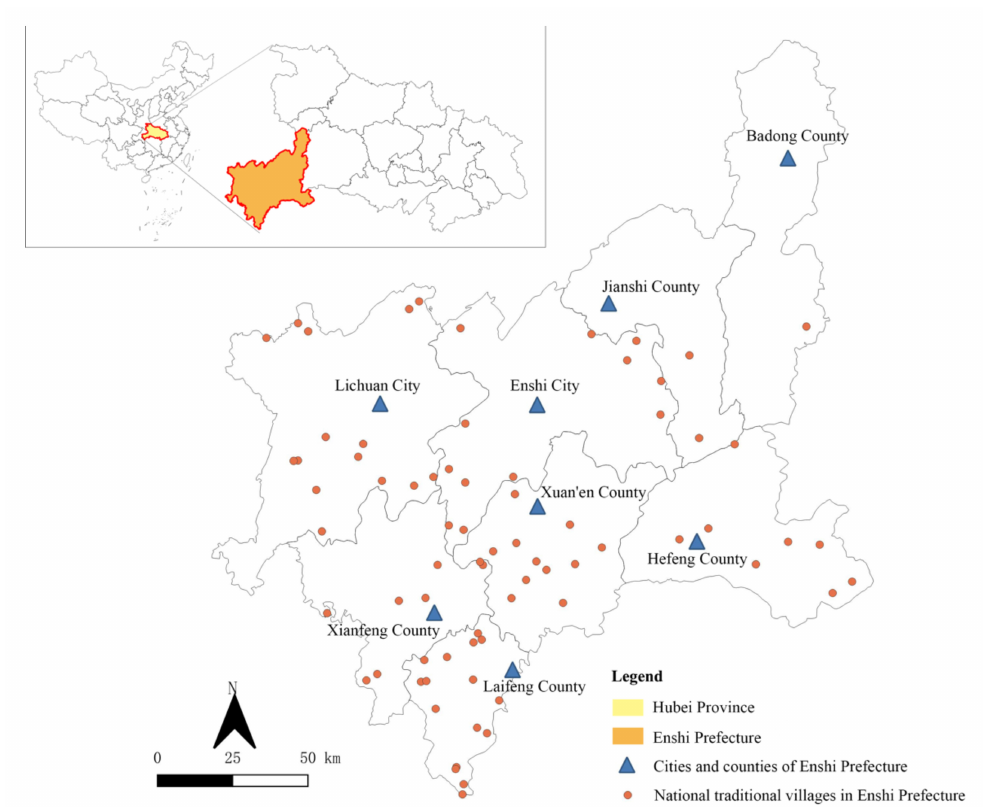
Figure 1. Location of Enshi Prefecture and the 73 national traditional